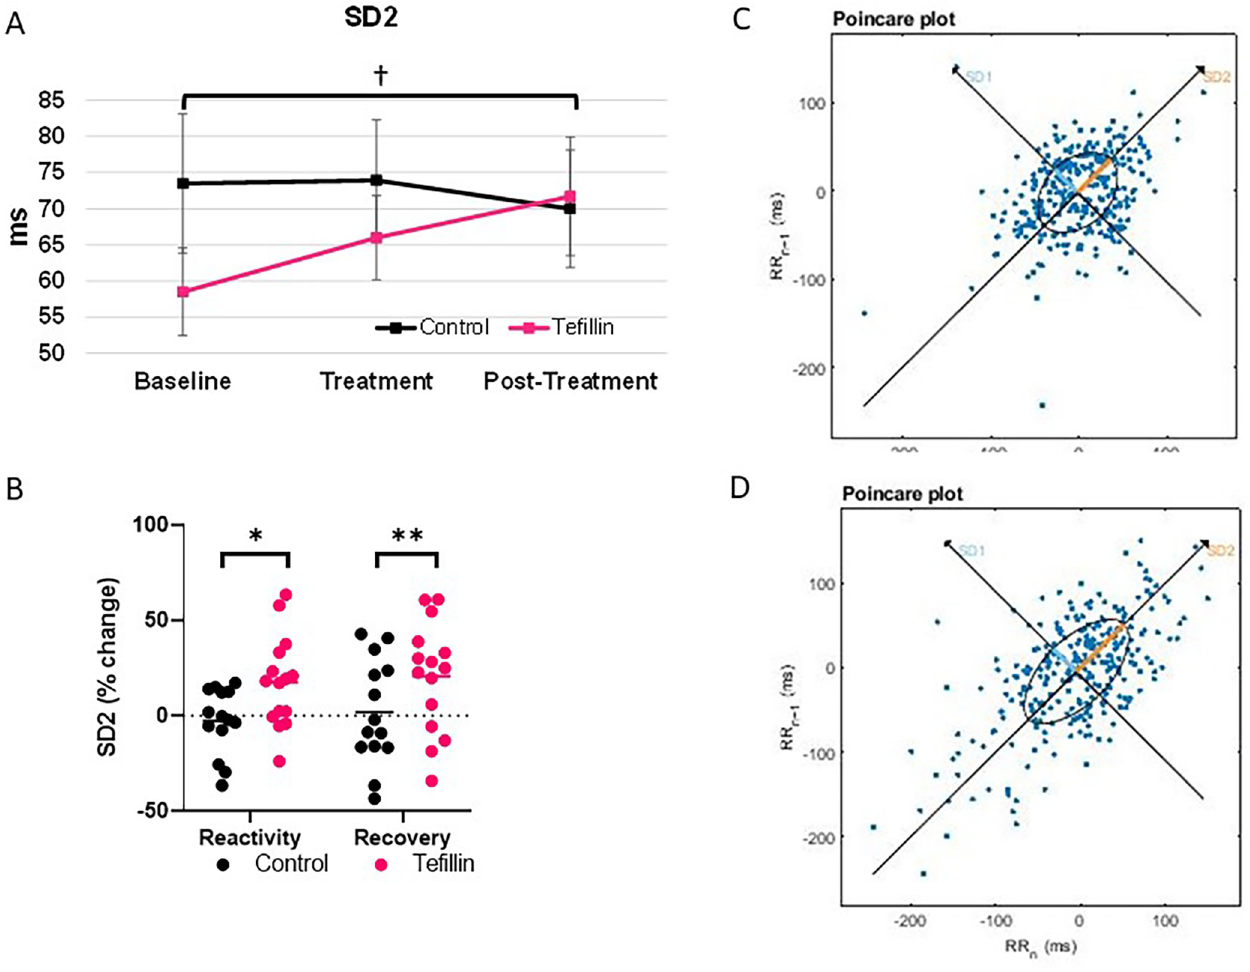
Fig 4. The frequency domain measurements were determined for control and tefillin subjects. Standard deviation–Poincare´ plot lengthwise (SD2) for A. absolute values and B. percent change. Absolute data represents an average of subjects during baseline, treatment and post-treatment ± SEM. Reactivity and recovery are the average differences between the baseline and treatment and treatment and post-treatment ± SEM, respectively. †P = 0.041 for tefillin baseline compared to tefillin post-treatment; � P < 0.05 for control versus tefillin at reactivity; and �� P < 0.05 for control versus tefillin at recovery. Representative Poincare´ plots from the Kubios software for C. tefillin at baseline and D. tefillin at